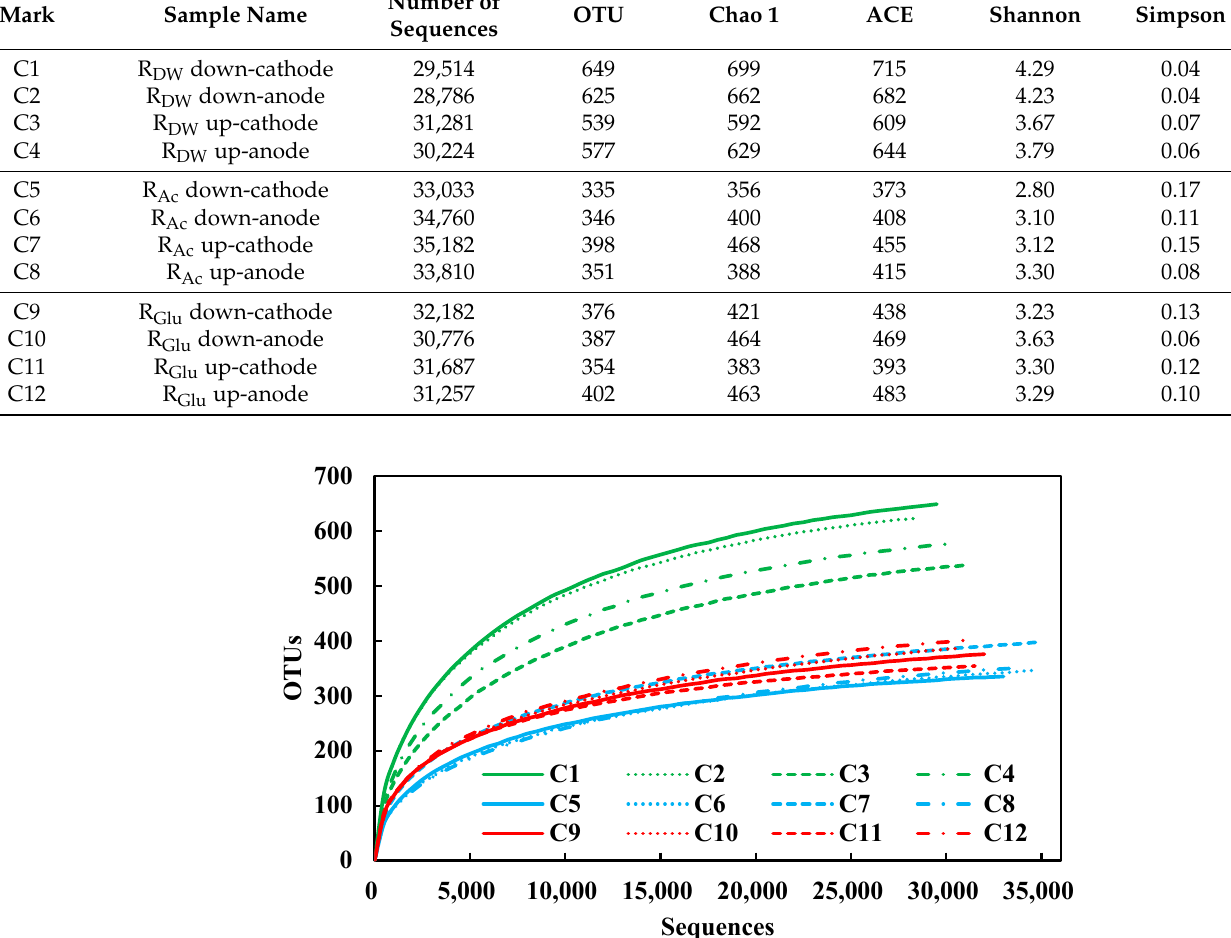
Figure 3. Principal component analysis (PCA) of microbial communities from different electron do- nor sources feeding BESs. Hierarchical cluster analysis was used to identify the differences of 12 microbial com- munities, as shown in Figure 4. Overall, microbial communities from R Ac and R Glu were